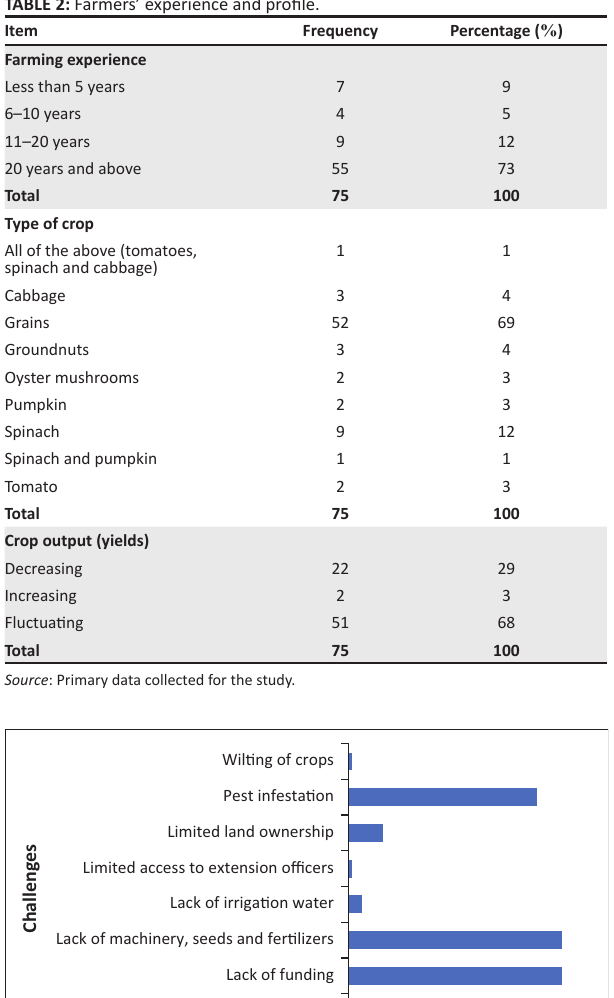
TABLE 2: Farmers’ experience and profile.